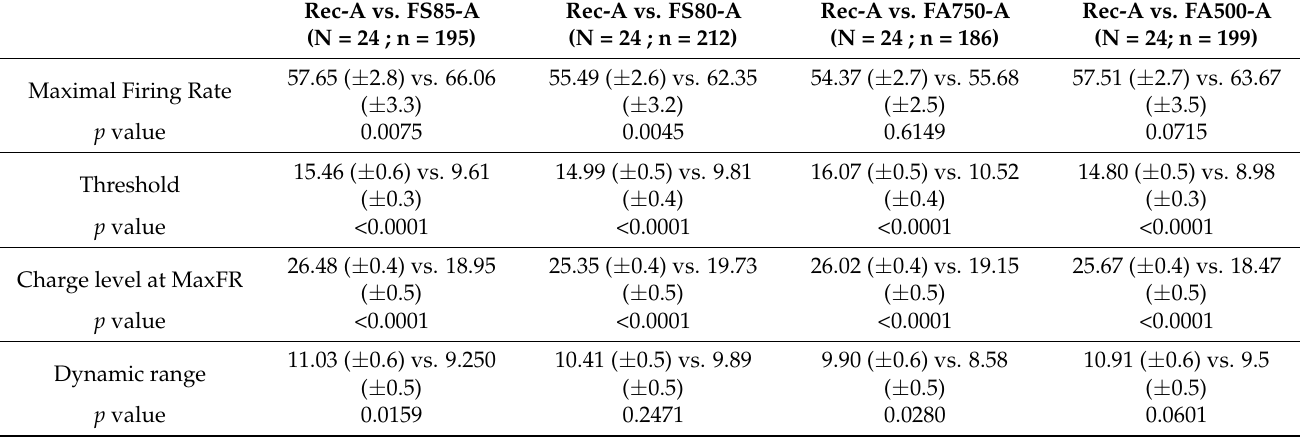
Table 2. Mean ± sem of the parameters extracted from the responses of ACx neurons with anodic- first pulses. For each comparison, N refers to the number of animals and n refers to the number of recordings providing significant responses to both pulse